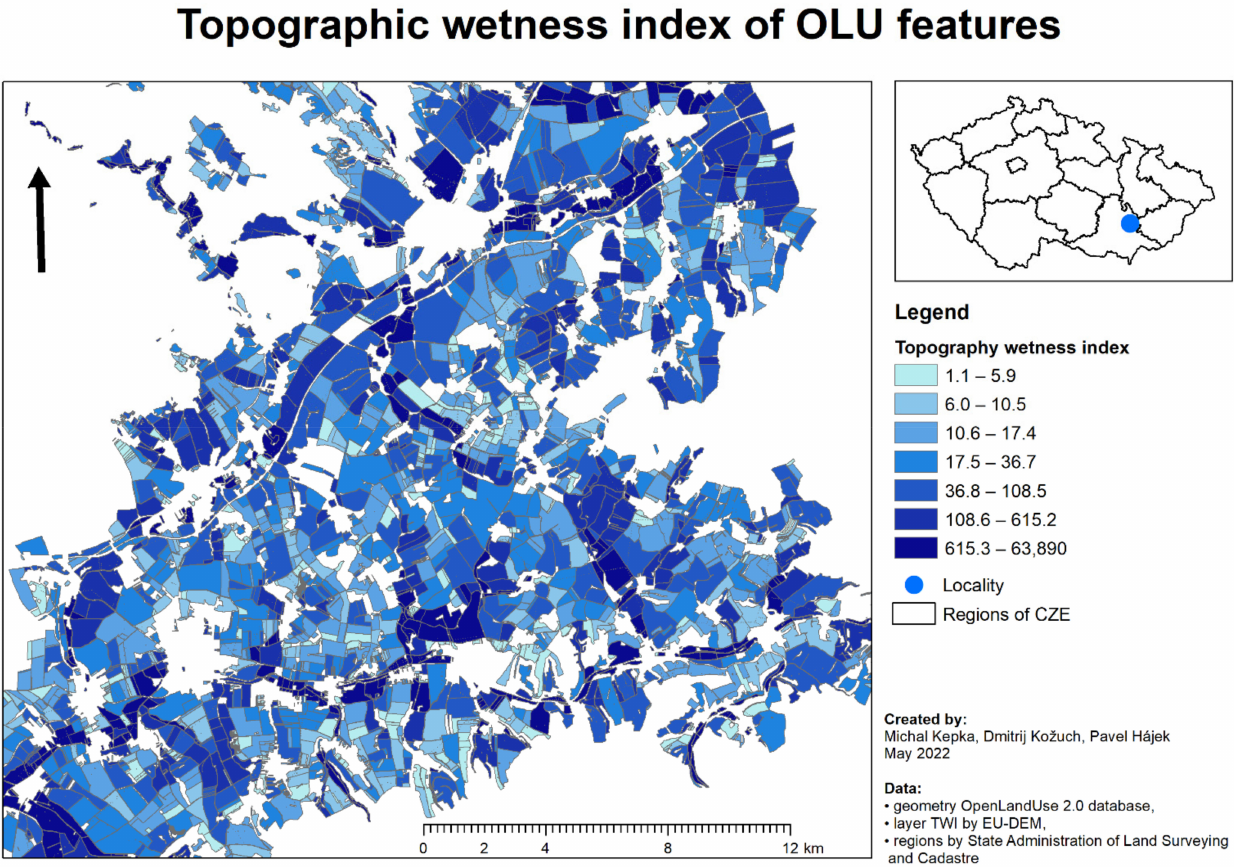
Figure 5. Example of a visualization of the topographic wetness index on OLU reference